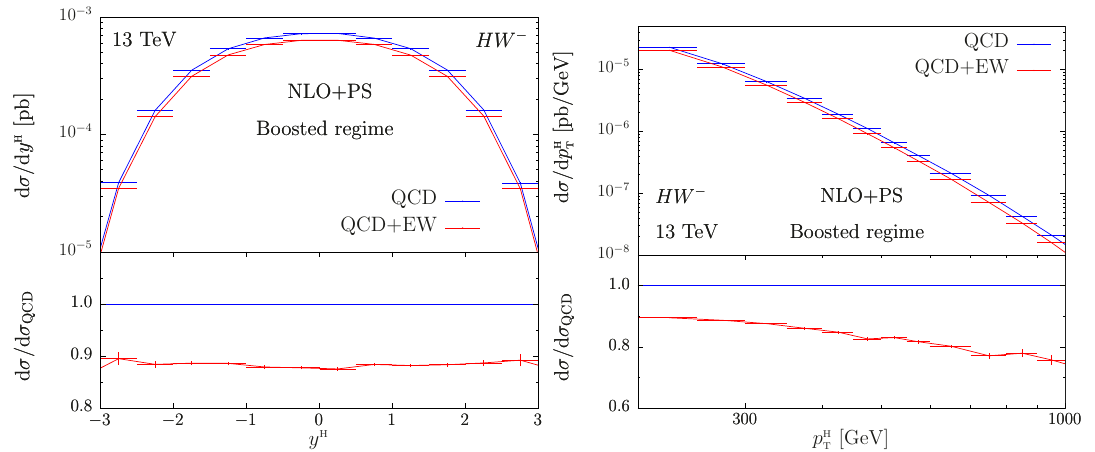
Figure 14. NLO+PS predictions for the rapidity (left) and the transverse-momentum distribu- tion (right) of the Higgs boson in the boosted regime of eq. (3.10) for HW (cid:0) production. Same curves and labels as in (cid:12)gure 12.